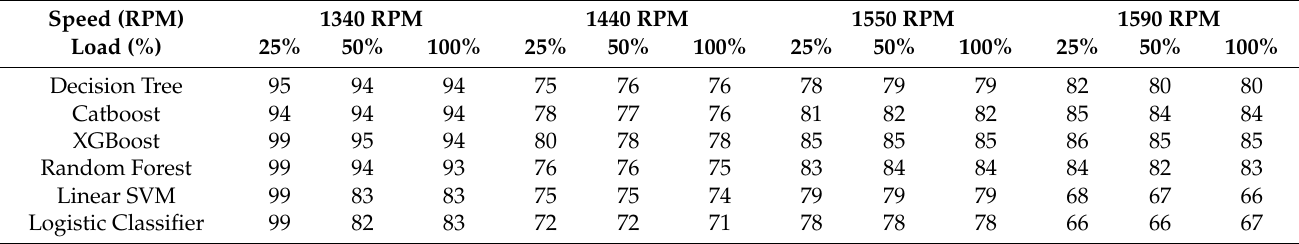
Table 6. Summary of validation accuracy in different operating conditions using mechanical signals.